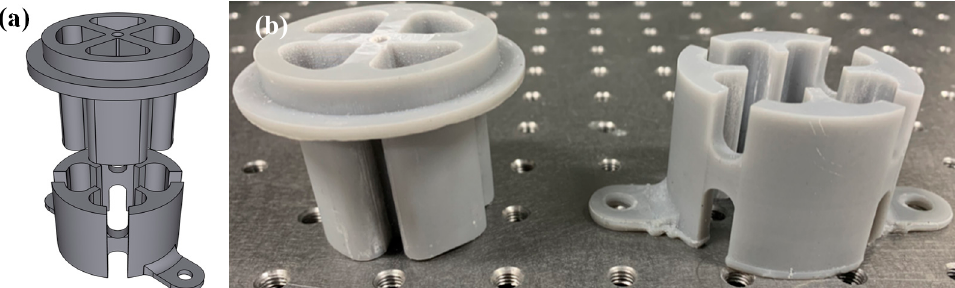
Figure 4. The 3D printed jig for loading test: ( a ) CAD draft; and ( b ) the fabricated top and bottom part of the Jig.